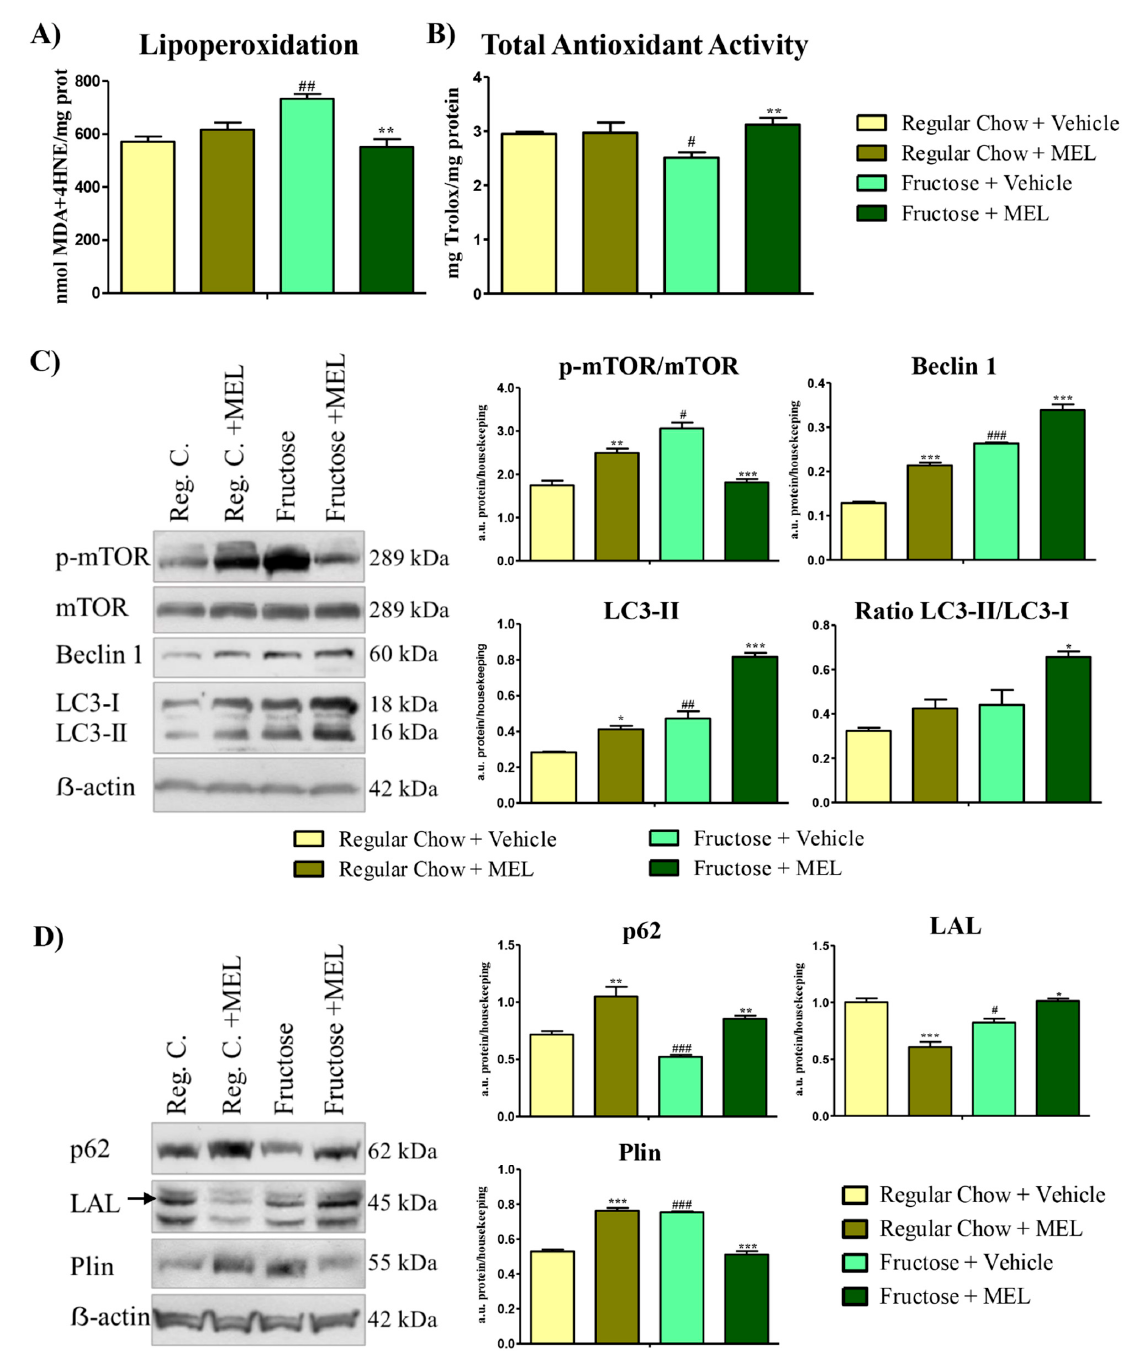
Figure 3. Melatonin ameliorates autophagic and lipophagic impairment in the Harderian gland in animals fed with fructose. ( A ) Harderian gland’s lipid peroxidation measured in nmols of 4-HNE+MDA/mg prot from hamsters fed with regular chow or fructose, with or without melatonin treatment (25 µ g of melatonin for 15 days). ( B ) Harderian gland’s total antioxidant activity measured in mg Trolox/mg protein from hamsters from all the above conditions. ( C ) Autophagy pathway proteins and LC3-II/LC3-I ratio in Harderian gland’s homogenates from hamsters from all conditions (quantified in histograms of protein expression/actin expression and mTOR is represent as p-mTOR/mTOR). ( D ) Lipophagy-related proteins expression in Harderian gland’s homogenates from hamsters from all conditions (quantified in histograms of protein expression/actin expression). Bars are mean ± SEM. * p < 0.05, ** p < 0.01, *** p < 0.001 (differences caused by melatonin treatment) and # p < 0.05, ## p < 0.01, ## p < 0.001 (differences caused by